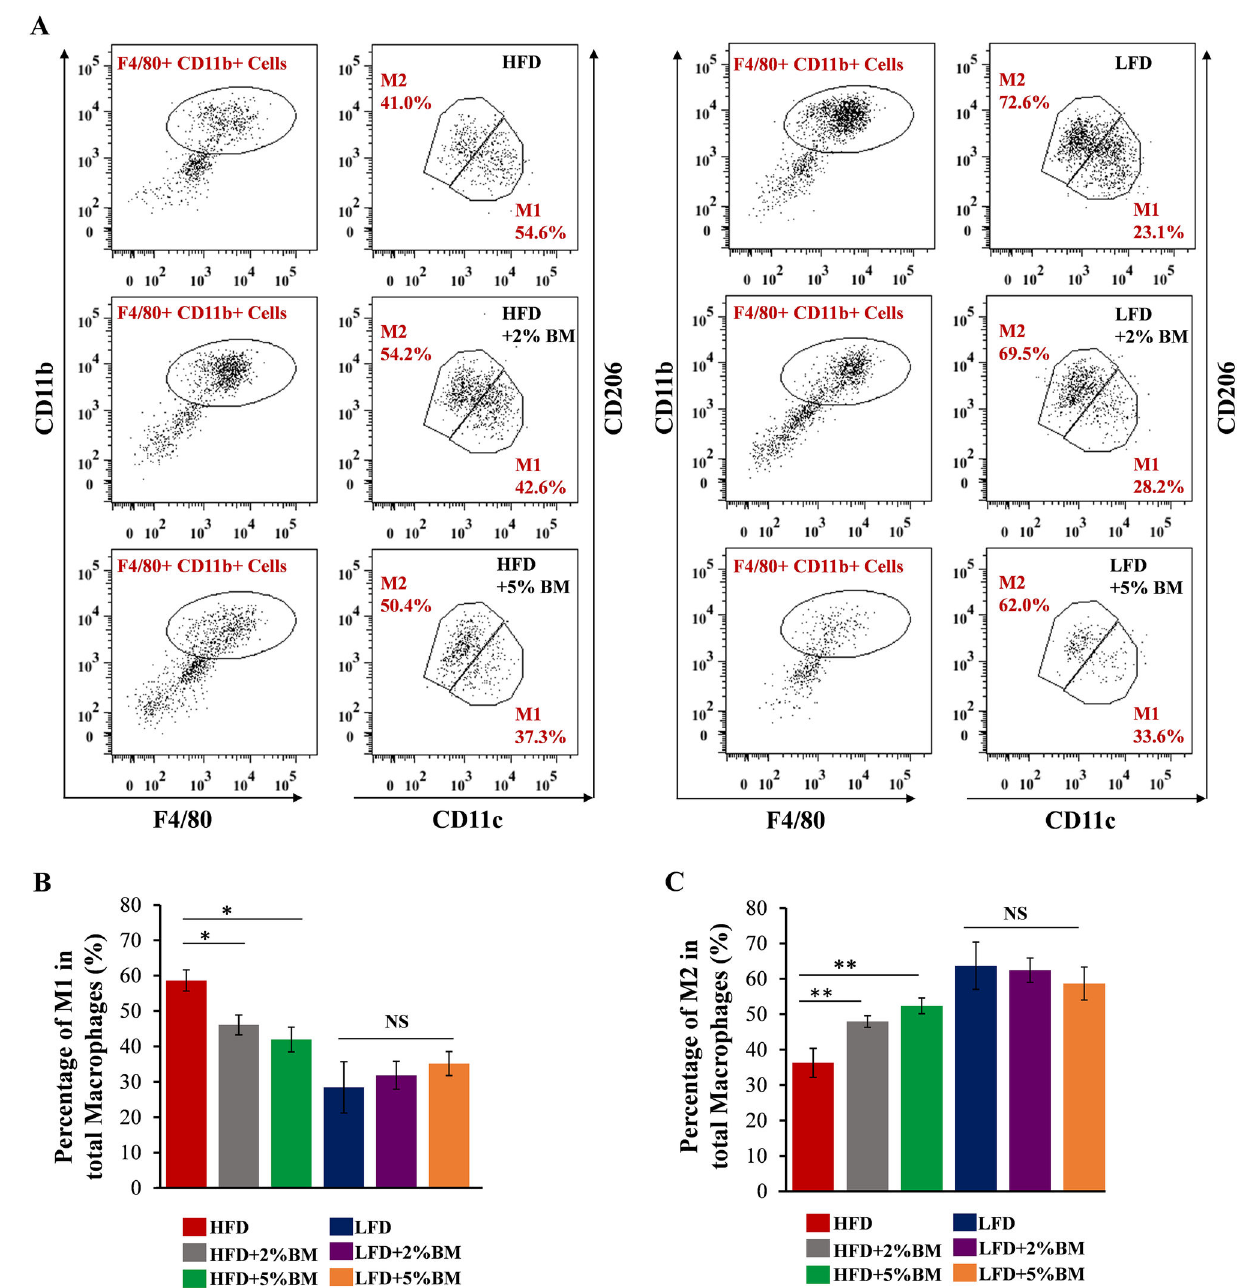
Figure 4. BM induced phenotypic switch in macrophage polarization in EAT of mice. (A) Analysis of SVF cells for M1 and M2 macrophage. SVF cells were stained with antibodies against F4/80, CD11b, CD11c, CD206, and analyzed by flow cytometry. Samples were gated for F4/80+ CD11b+ cells, then examined for coexpression of CD11c or CD206. M1 and M2 macrophage and their percentage were indicated in red. (B and C) Quantitation of percentage for M1 and M2 macrophage in total F4/80+ CD11b+ cells. Statistical difference between groups is shown using a nonparametric Mann-Whitney test. n=6 per group. * P <0.05, ** P <0.01. All data in (B)-(C) are means ± SEM. doi: 10.1371/journal.pone.0084075.g004 Correspondingly, BM-contained diets also depressed the 6C). We reported previously that genetic deficiency and expression of mast cell maker gene mMcp-6 in EAT (Figure pharmacological stabilization of mast cells can increase energy